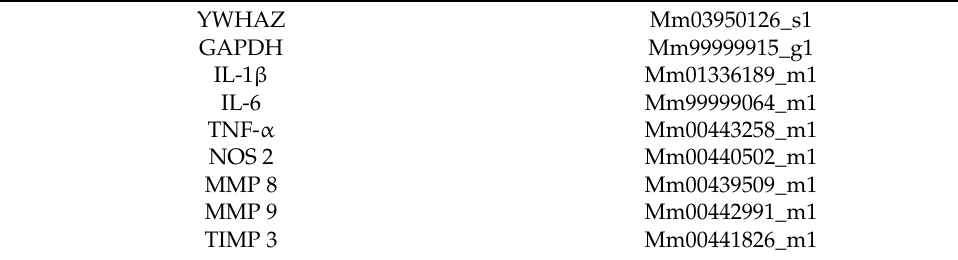
Table 2. List of the TaqMan probes employed in this experiment and their